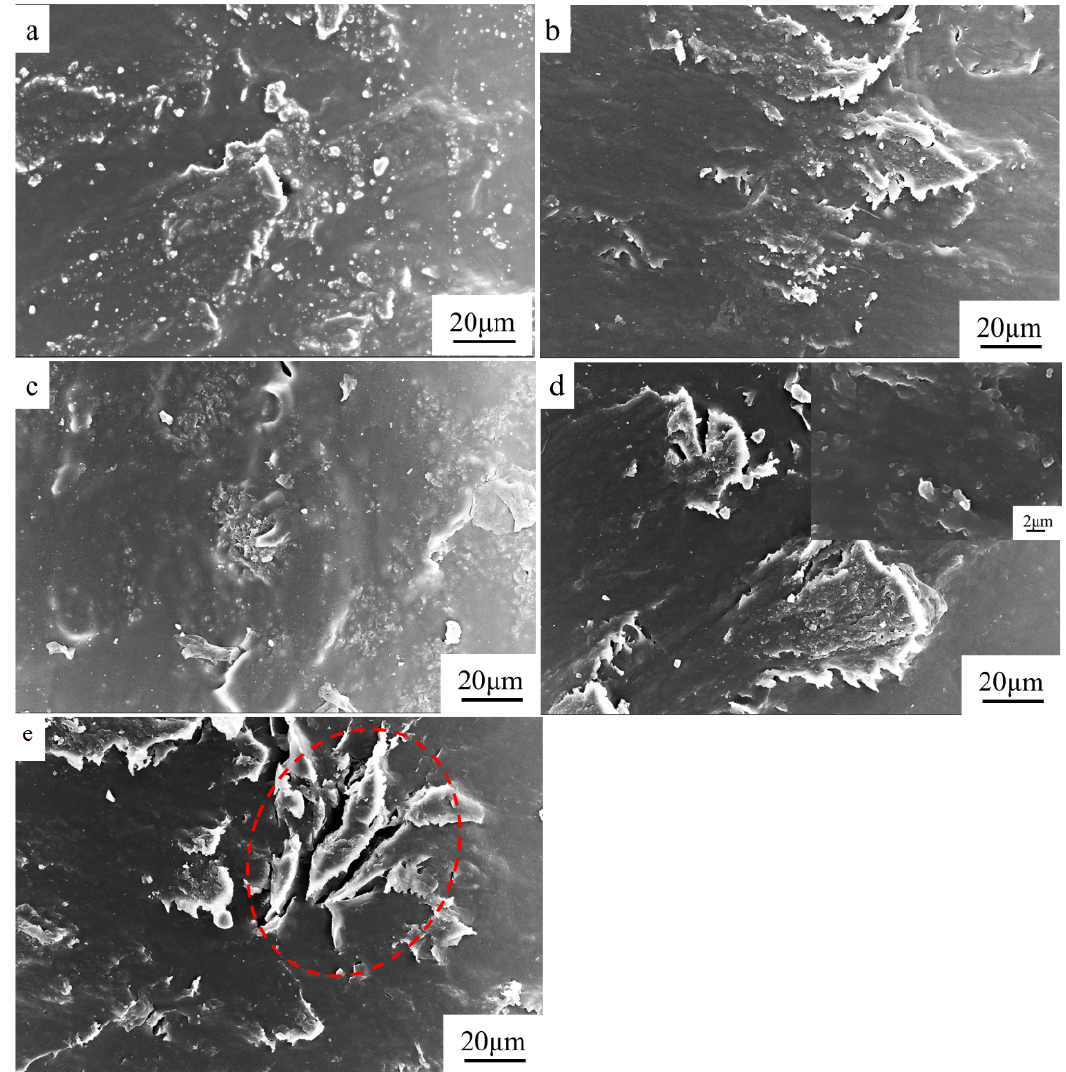
Figure 4. Scanning electron microscope (SEM) images of surface morphology of the composite films prepared with the initial TPU concentration of 20 wt% and the RGO mass content of 0.4 wt% ( a ), 1.5 wt% ( b ), 3 wt%( c ), 5 wt% ( d ), and 7 wt% ( e ), respectively. The inset in ( d ) is local